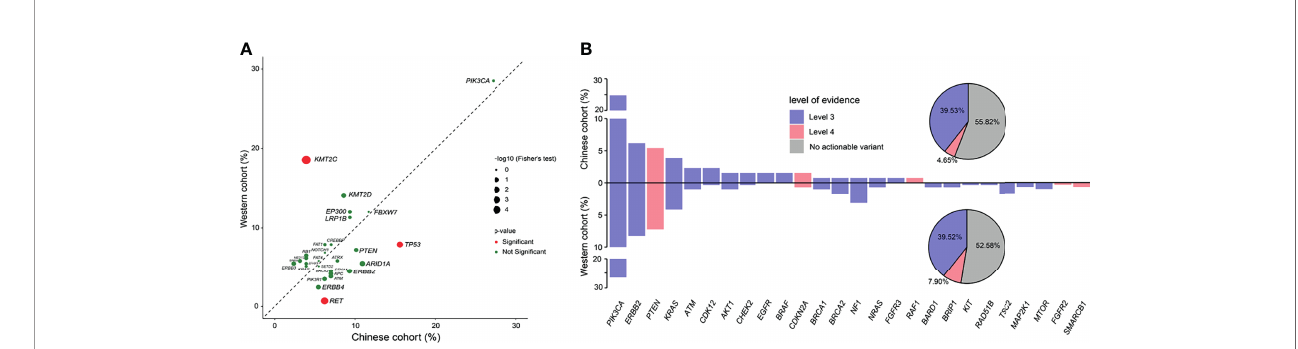
FIGURE 2 | Comparison of genomic and actionable alterations of cervical cancer patients between the Chinese cohort and the TCGA cohort. (A) Comparison of the prevalence of gene alterations identi fi ed between Chinese and Western cervical cancer patients. (B) Comparison of the actionable alterations identi fi ed between Chinese and Western cervical